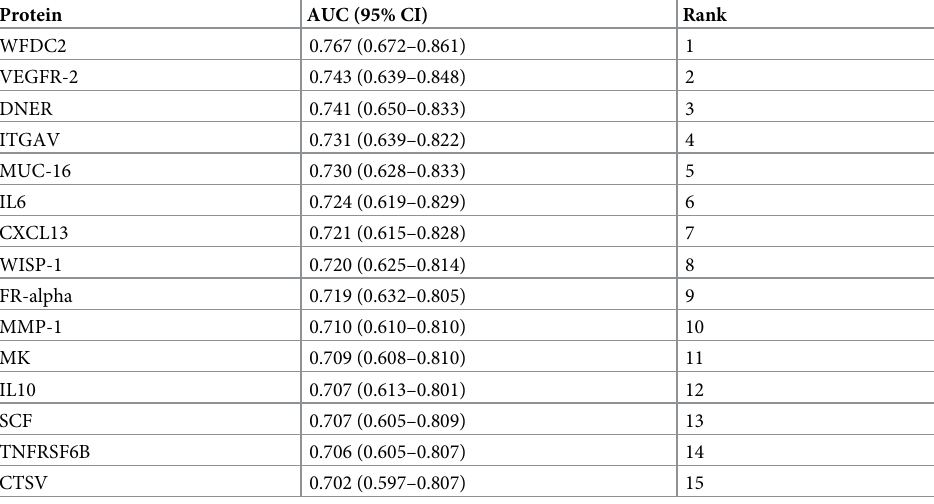
Table 7. AUC for individual biomarkers. Benign tumors vs. borderline + cancer, AUC >